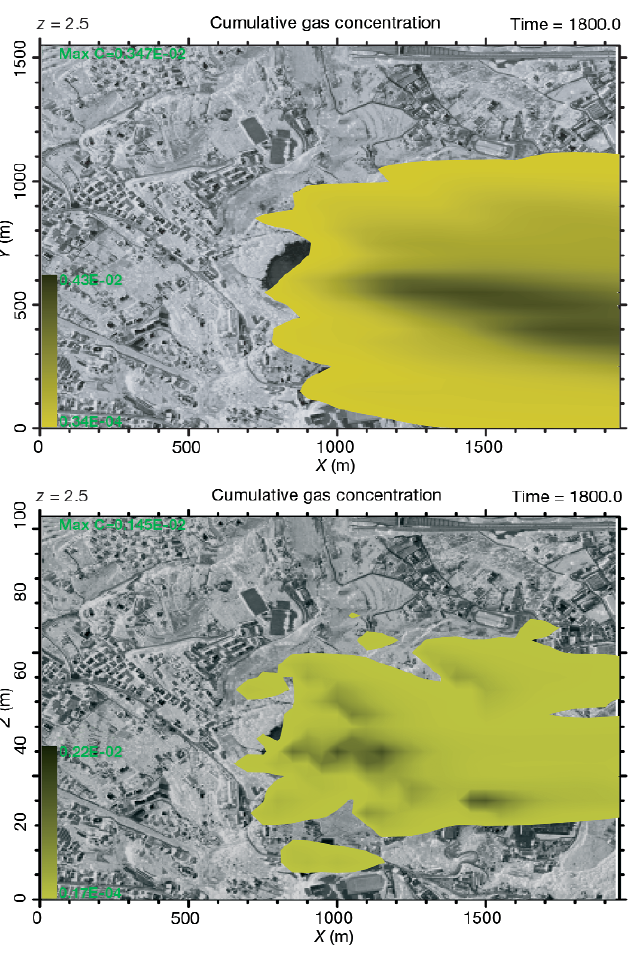
Fig. 5. Simulated gas concentration values at 2.5 m level for the 8th June 2001 ( top ) and the 13th June 2001 ( bottom ) events. Time is in seconds, lengths are in meters and concentration values in kg/m 3